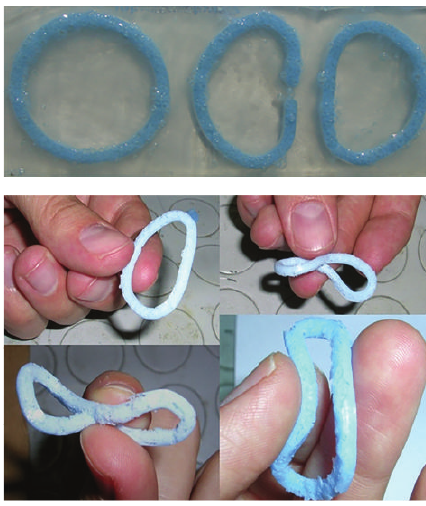
Figure4:ExampleoftheobtainedporousPDMSannuloplastyrings aimed at valve tissue repair. Image from the PDMS rings casted into the rapid epoxy mold and details from the final parts.